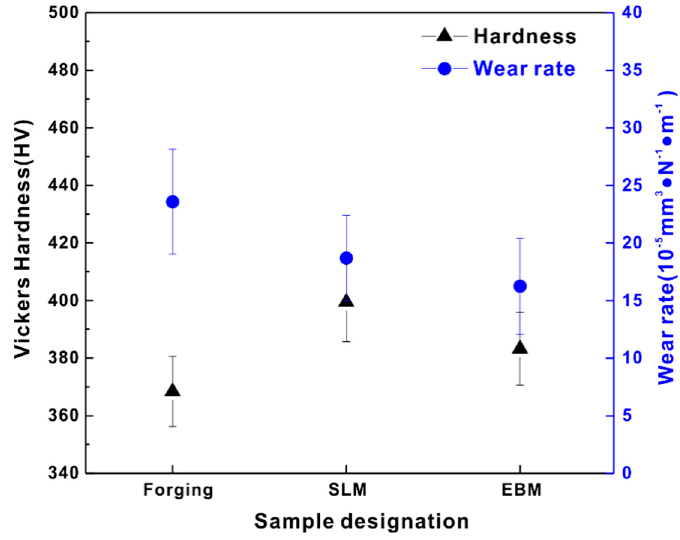
Figure 5. Hardness and wear rate of Ti-6Al-4V samples fabricated by forging, SLM and EBM.